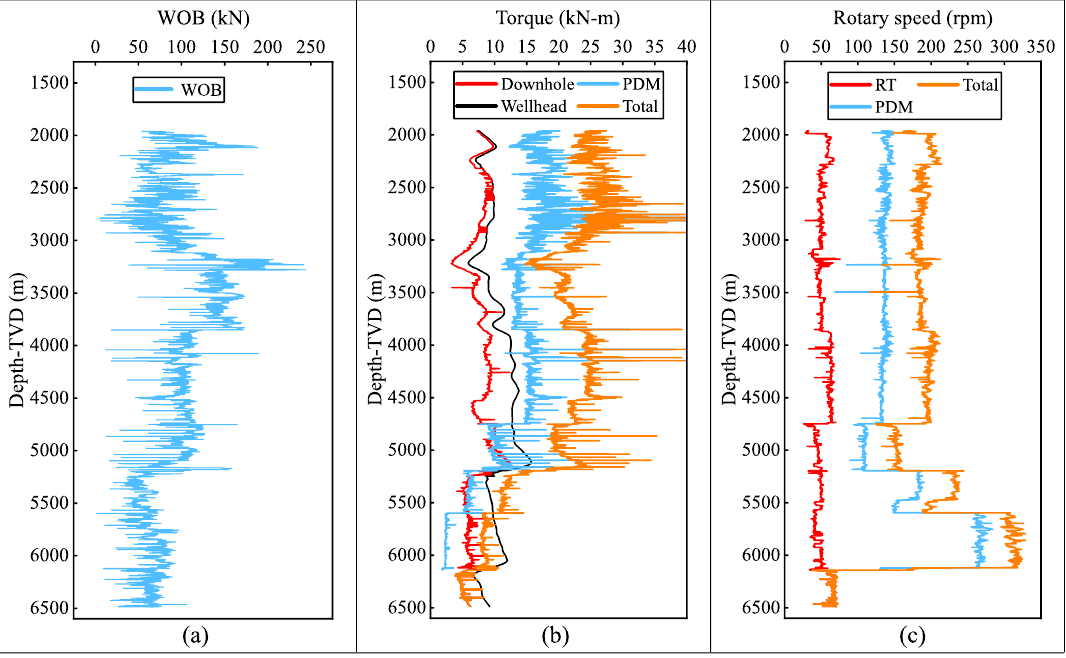
Figure 3. Drilling parameters under compound drilling for well M. ( a ) shows the weight on bit data; ( b ) plots the theoretical total torque on the bit, considering downhole friction and PDM; ( c ) presents the theoretical rotary speed of the bit under compound drilling.